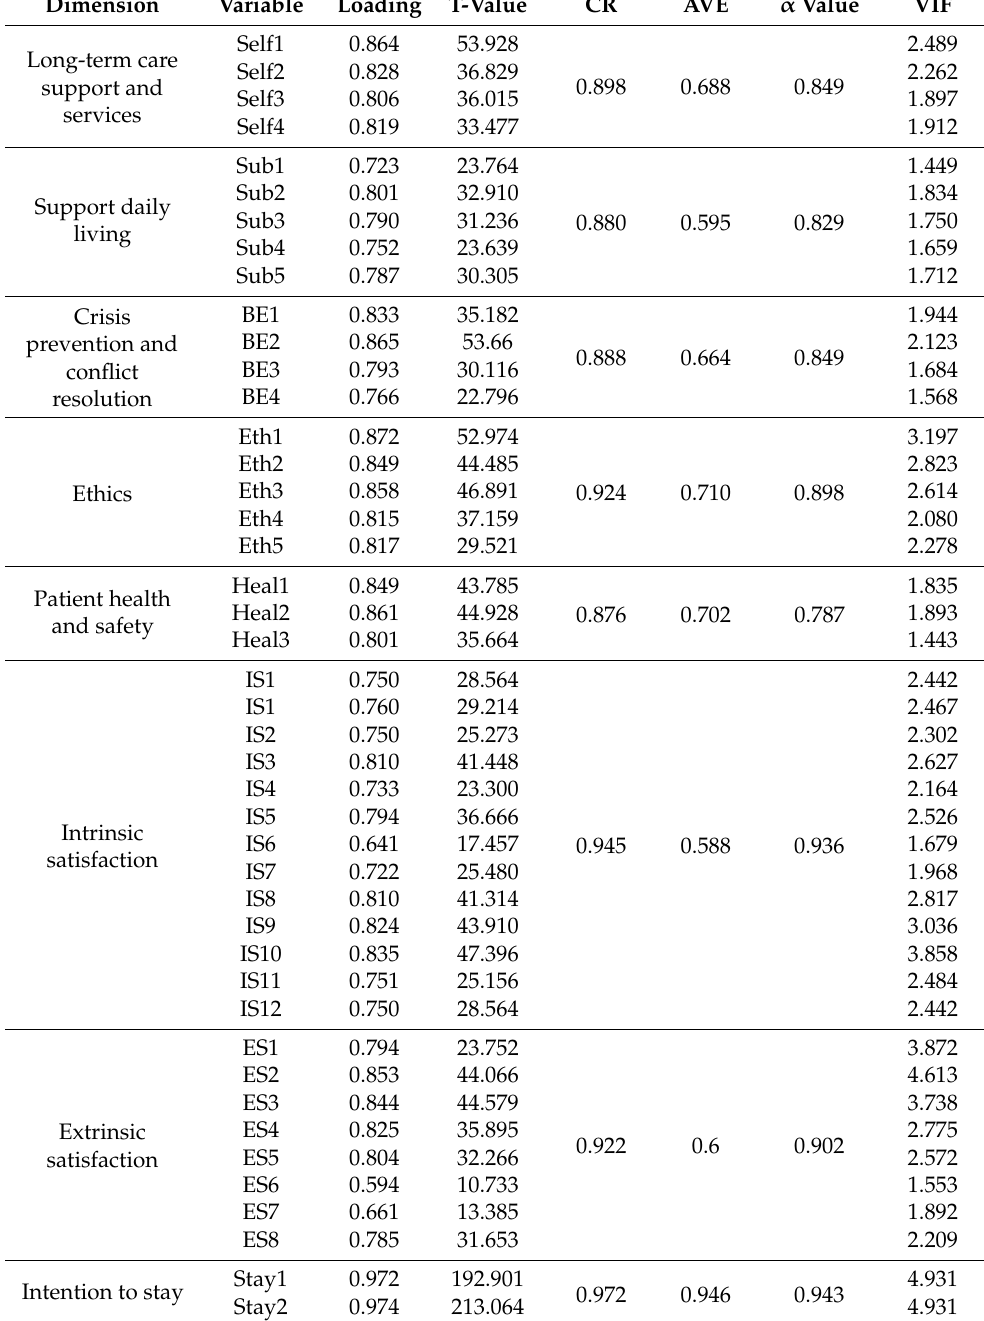
Table 1. Reliability and convergent validity of the reflective metrics. Dimension